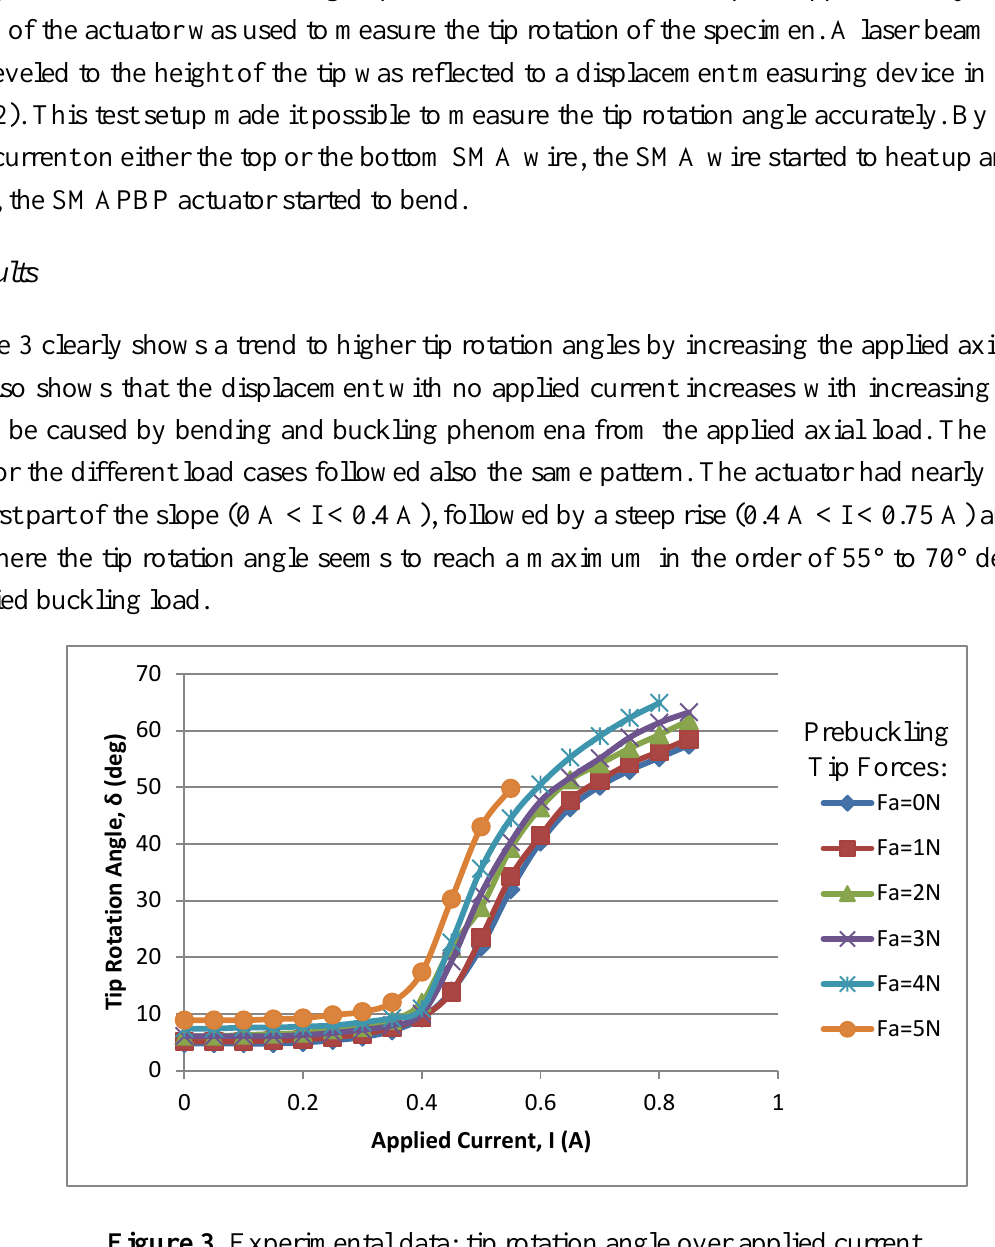
Figure 3. Experimental data: tip rotation angle over applied